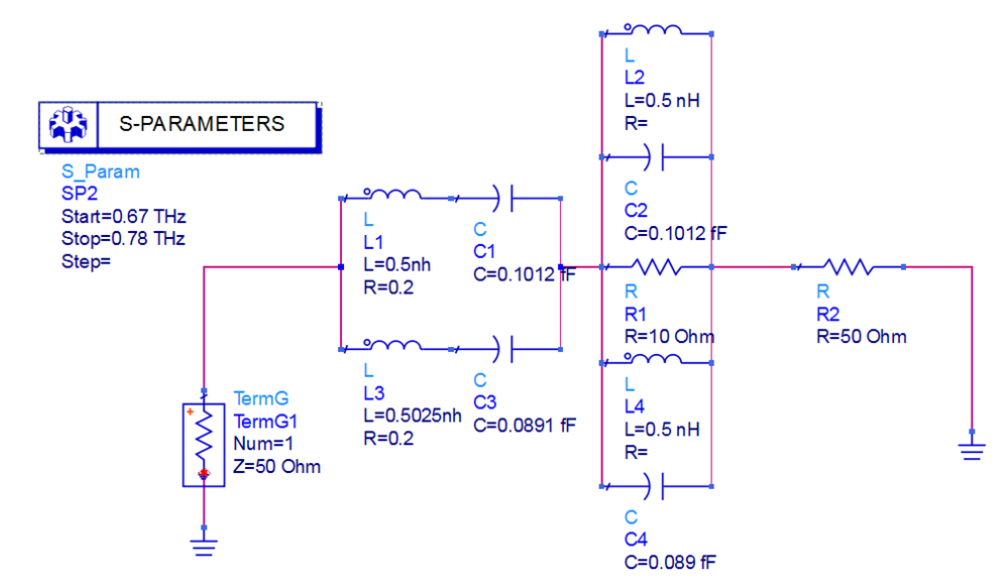
Figure 6. Equivalent circuit model of dual-band THz